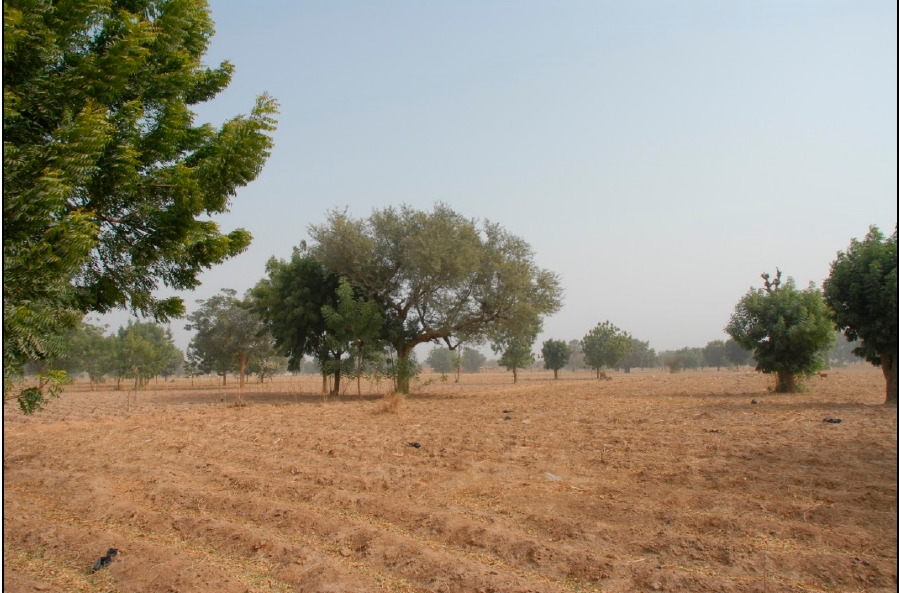
Figure 2. A fallow agricultural field with different tree species in the Kano Close Settled Zone, Northern Nigeria, during the dry season (January 2016). Table 2. Dominant agroforestry tree species, number of tree species in the sample, and their crown